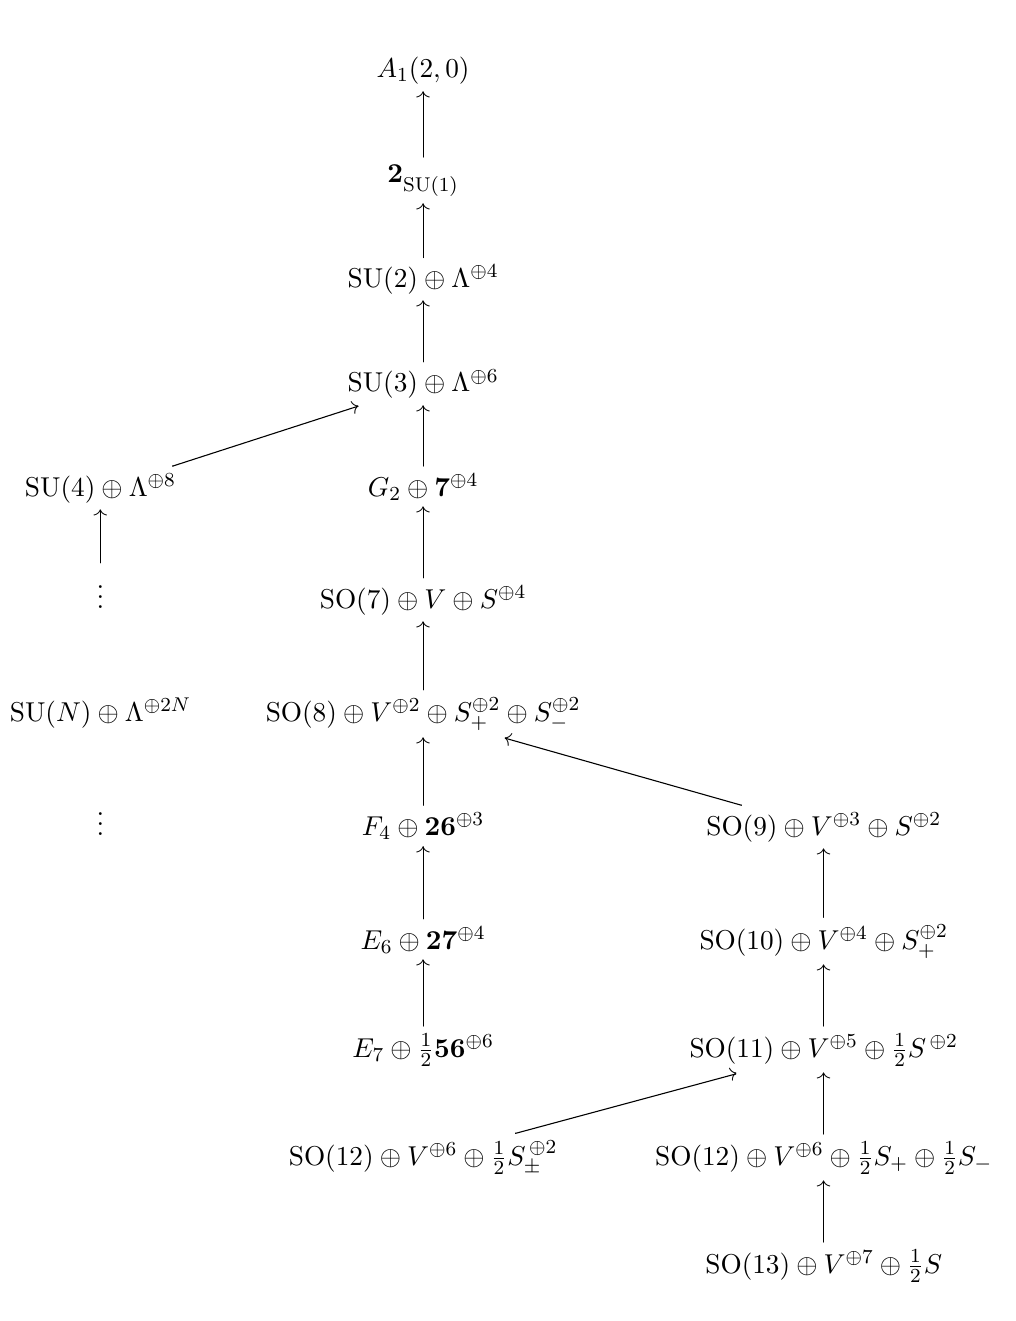
Figure 4. The M-string Higgsing